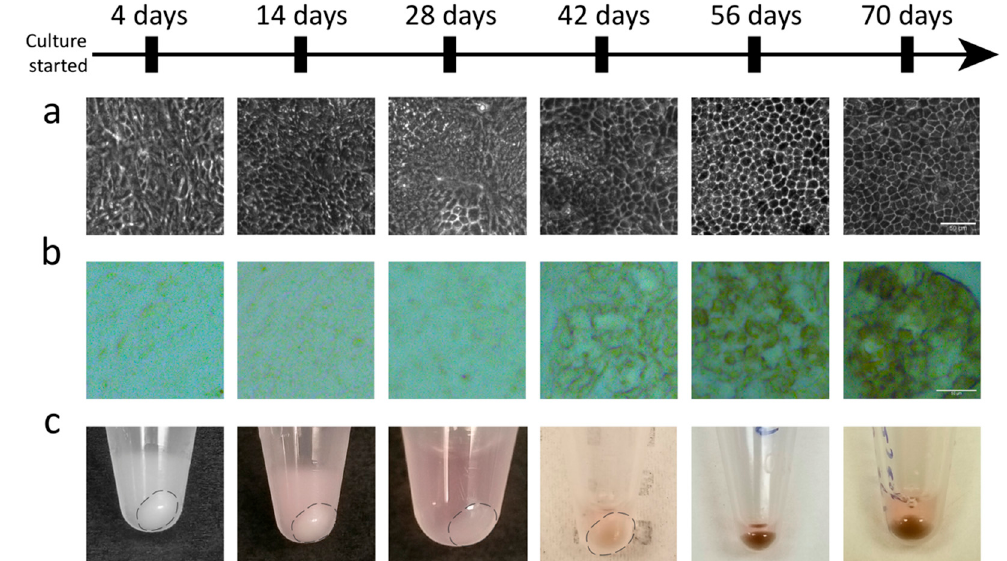
Figure 1. Embryonic stem cell-derived retinal pigment epithelium (E-RPE) cultures demonstrate morphological changes and become pigmented as they mature. ( a ) Cellular morphology of E-RPE cultures develops over time to make the consistent hexagonal shaped cells seen at 56 and 70 days. ( b ) Representative micrographs of the progressive pigmentation of the E-RPE culture as it matures. ( c ) Cell pellets in microcentrifuge tubes of E-RPE cultures sampled at confluency (4 days), 14 days, 28 days, 42 days, 56 days and 70 days show increasing pigmentation over time. Scale bars represent lengths of 50 µm in ( a ) and ( b ).